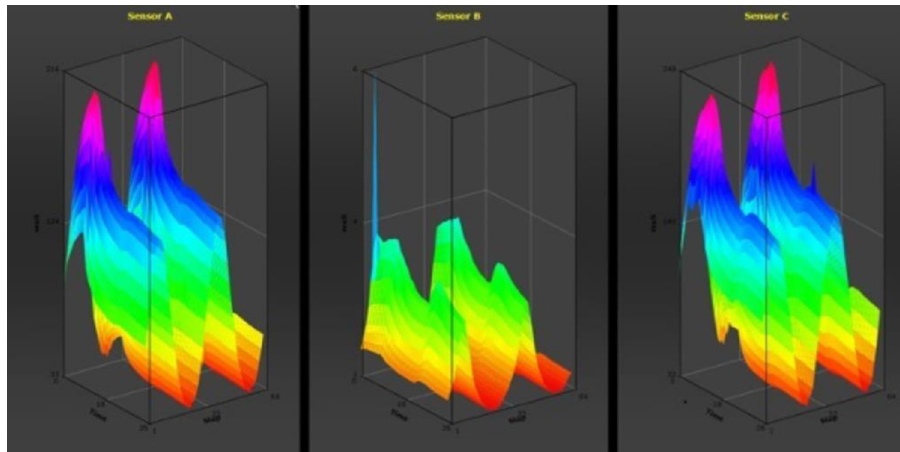
Fig 2. Raw sensor signals from the electronic